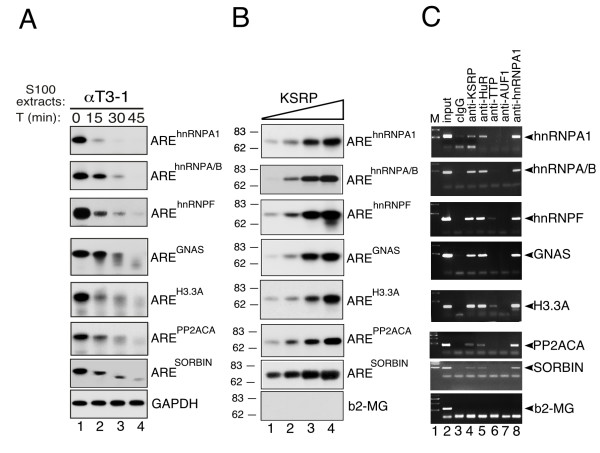
KSRP associates with a set of unstable mRNAs overrepresented in myrAKT1-αT3-1 cells. (A) In vitro RNA degradation assays using S100 extracts from αT3-1 cells. Internally 32P-labeled, capped RNA substrates (see Additional file 4 for sequences) were incubated with extracts for the indicated times and their decay analyzed as described in Methods. (B) The interaction between 32P-labeled RNAs (indicated on the right) and recombinant purified KSRP (30–300 nM) was evaluated by UV-crosslinking. (C) Immunoprecipitation of ribonucleoprotein complexes containing different KSRP target mRNAs. The proteins were immunoprecipitated from αT3-1 cell extracts using the indicated antibodies. RNA was extracted from the immune complexes and analyzed by RT-PCR as described in Methods.